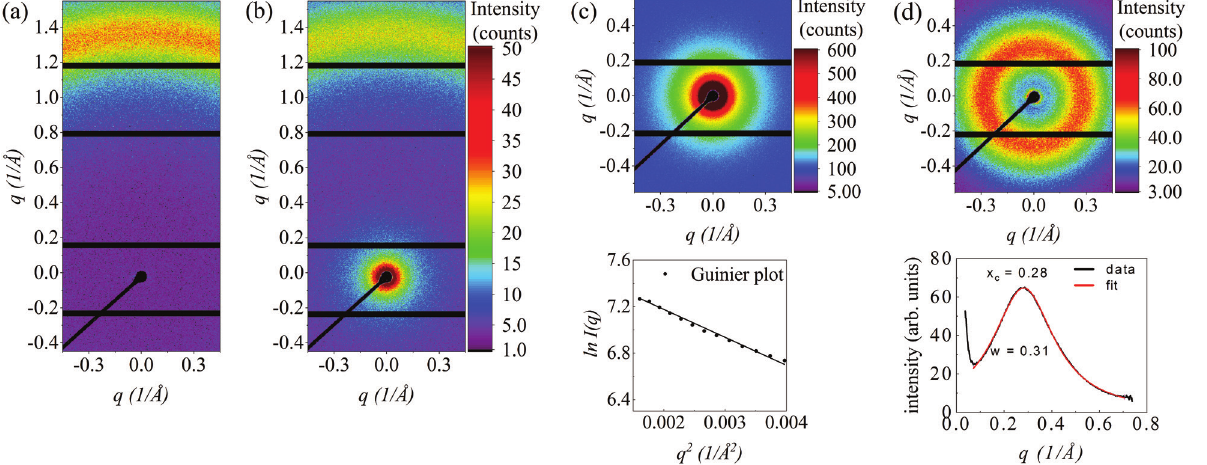
Figure 4: SAXS/WAXS reciprocal space maps of GeNP used to determine inter/intra-particle structure and distances. (a) Reciprocal map of solvent in capillary. (b) Reciprocal map of dissolved GeNP in capillary. (c, top subfigure) Reciprocal map of dissolved GeNP in capillary with longer acquisition. (c, bottom subfigure) Guinier plot obtained from reciprocal map (Figure 4c, top subfigure). (d, top subfigure) Reciprocal space map of powder GeNP in capillary. (d, bottom subfigure) Line-cut with its fit obtained by circular gathering of reciprocal space map (Figure 4d, top subfigure).